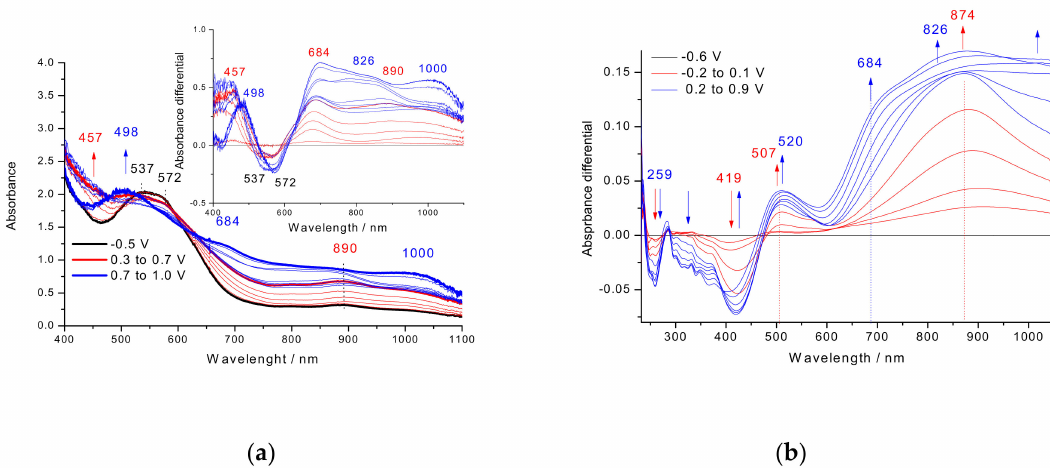
Figure 6. Change in absorbance of UV-Vis-NIR at the first ( red ) and second oxidation peak ( blue ) of 3 in 1mM solution of monomer in 0.1 M Bu 4 NBF 4 /DCM solution, difference absorbance vs wavelength ( insert ) ( a ), difference UV-Vis-NIR absorbance during oxidative polarization of p(3) in 0.1 M Bu 4 NBF 4 /DCM solution ( b